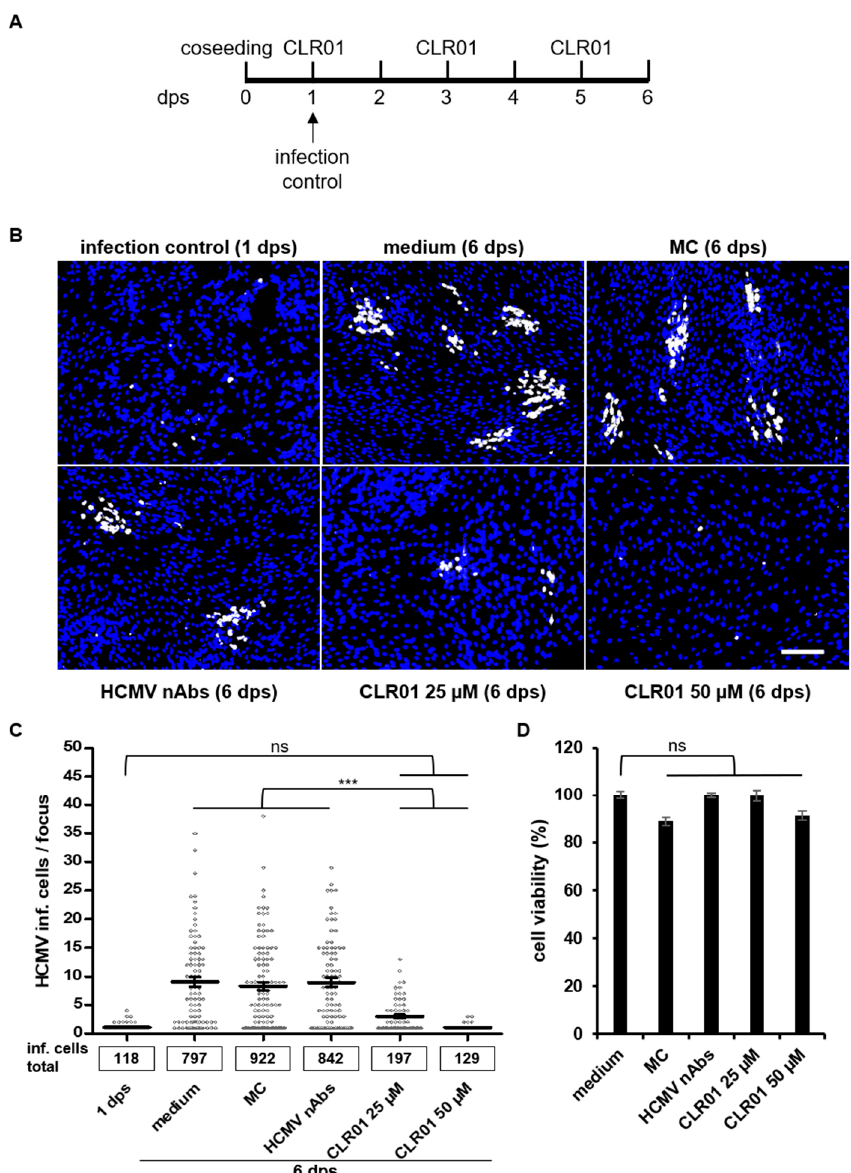
Figure 5. CLR01 inhibits direct cell-to-cell spread of a clinical HCMV isolate. ( A ) Human fibroblasts were seeded together with cells infected with a clinical HCMV isolate. Different conditions (medium, methylcellulose (MC) overlay, HCMV-neutralizing antibodies (nAbs; 5 mg/mL Gamunex), and indicated concentrations of CLR01) were applied 1 day post seeding (dps) and renewed every 48 h. Focal growth was determined by indirect immunofluorescence of HCMV IE antigen at 6 dps. Initial infection was controlled by detection of HCMV-positive cells at 1 dps. ( B ) Blue, DAPI-positive cells; white, HCMV-positive cells. Scale bar is 200 µm. ( C ) Means ± SEMs. Each data point represents the number of HCMV-infected cells per focus quantified from images from B. ( D ) Cell viability of human fibroblasts cultivated under indicated conditions for 6 days at 37 °C was controlled using the MTT assay. Means ± SDs are from the combined results of two individual experiments, each performed in triplicate. Controls (medium) were set to 100% and samples normalized accordingly. ***, p < 0.0001.